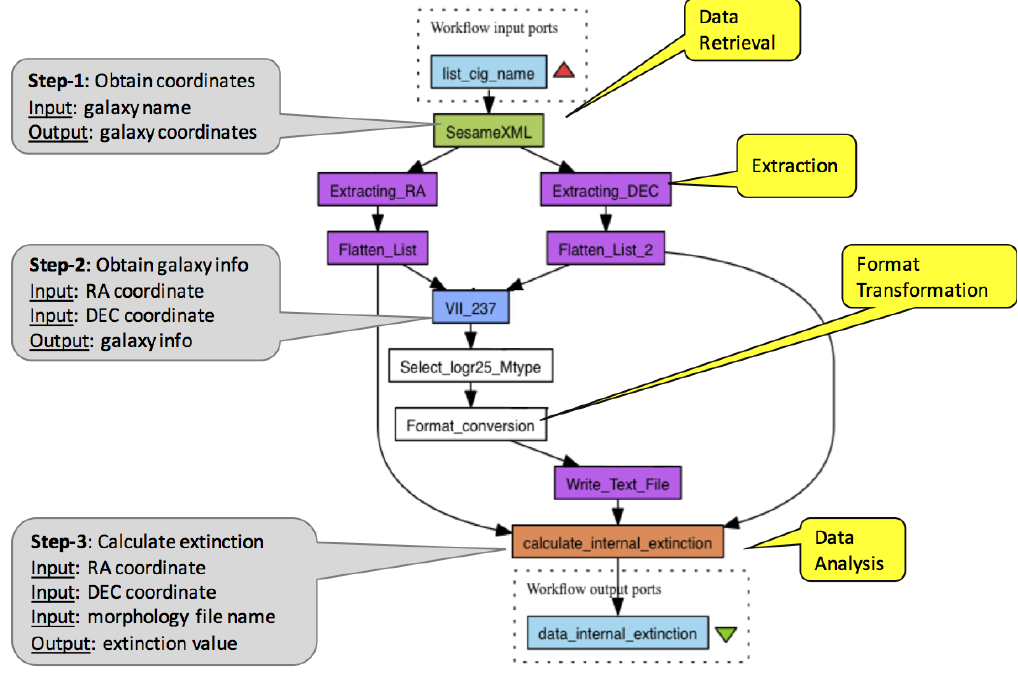
Figure 1. Sample workflow from Astronomy developed by the Wf4Ever project that takes as input a set of galaxy names, and outputs extinction values per